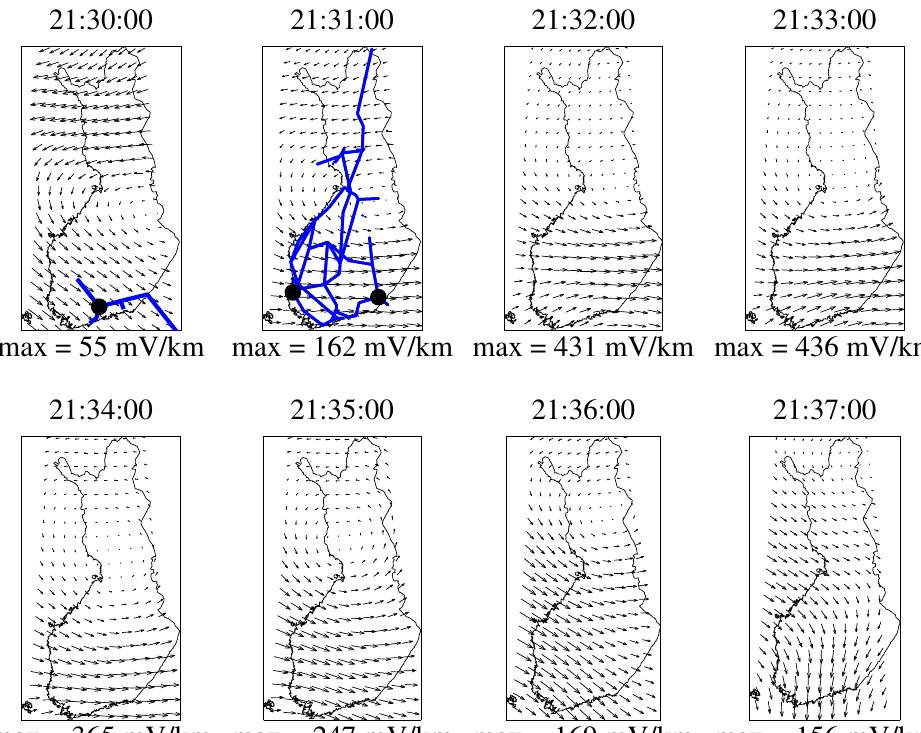
Fig. 7. Snapshots of the calculated electric field on 11 April 2001, using the local 1-D method and the Earth model of Table 2. The main parts of the Finnish natural gas pipeline are sketched in the first plot with blue lines, and the measuring site at M¨ants¨al¨a is marked as a black dot. The Finnish 400kV and 220kV power lines are shown in the second plot with blue lines. The Rauma and Yllikk¨al¨a 400kV transformers are the black dots in the west and east, respectively.